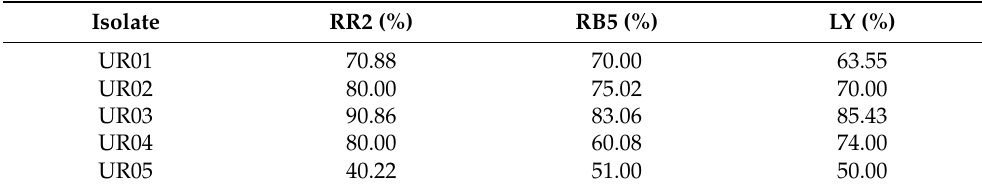
Table 1. Azo dyes degradation ability of Paramecium isolates. Percent decolorization is indicative of degradation ability.